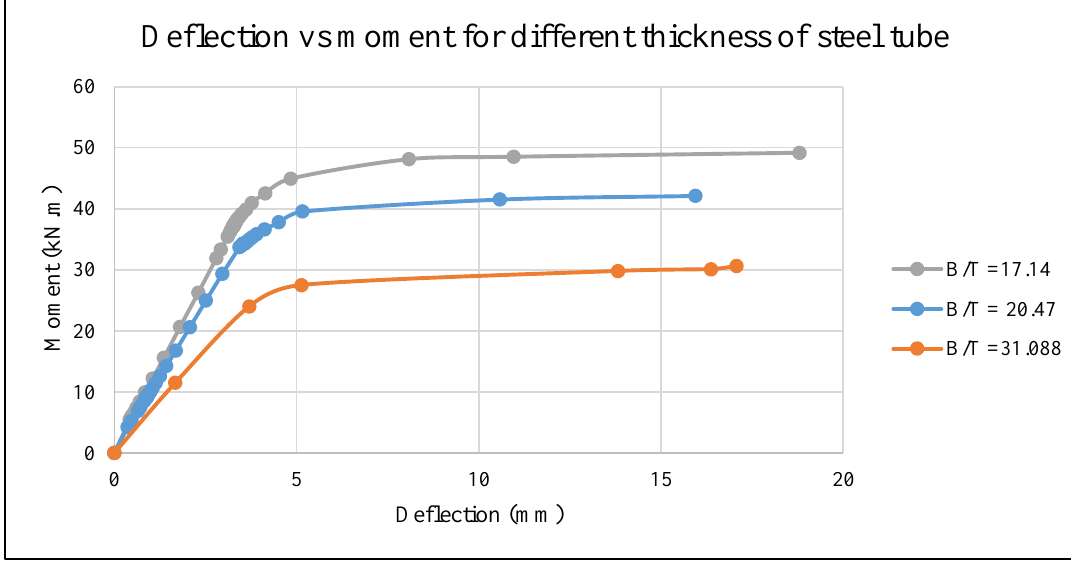
Fig. 8. Deflection vs moment at different